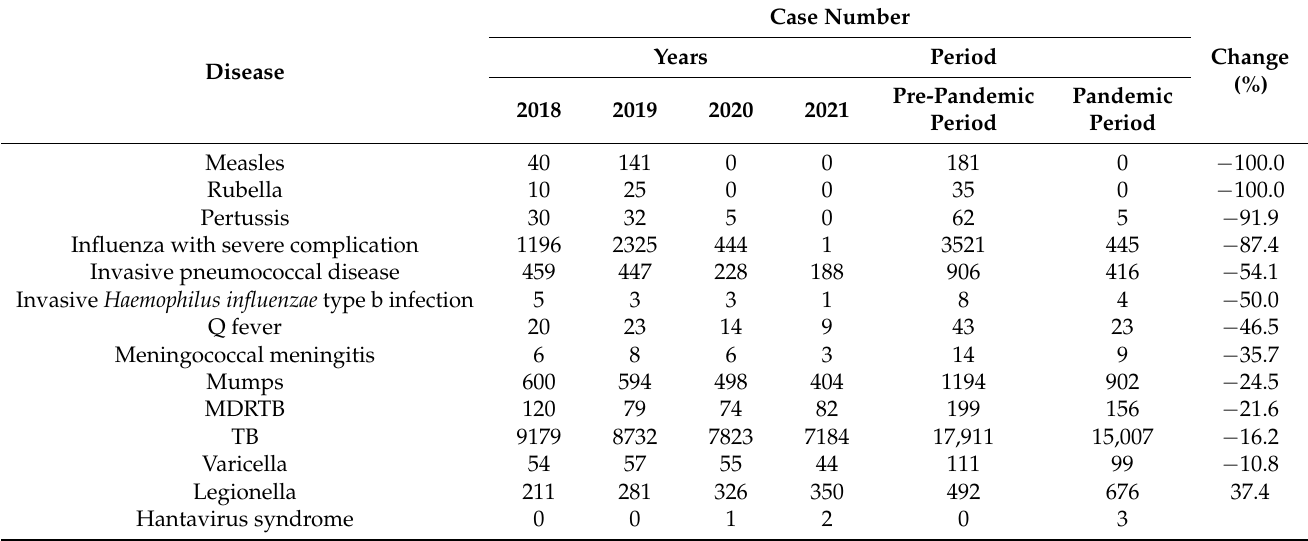
Table 1. The case number of airborne/droplet-transmitted notifiable infectious